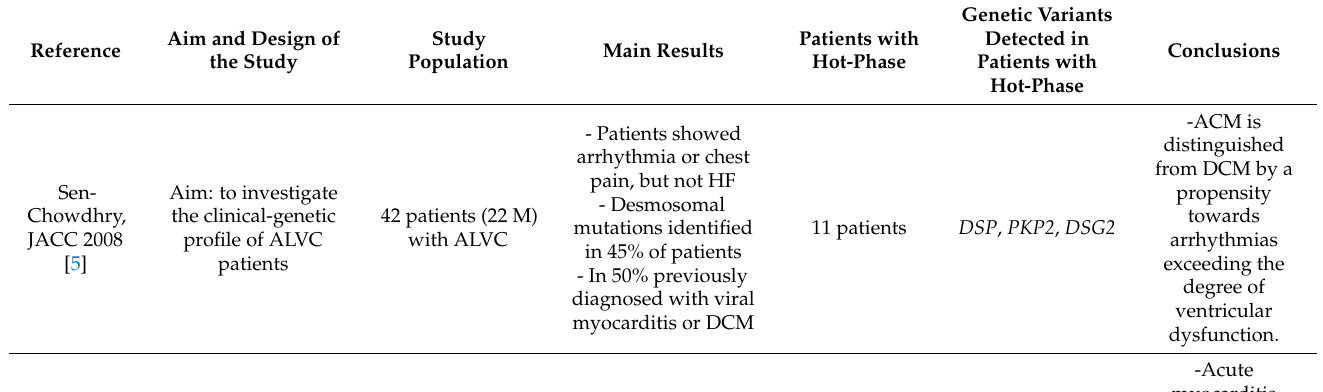
Table 1. Studies included in the systematic